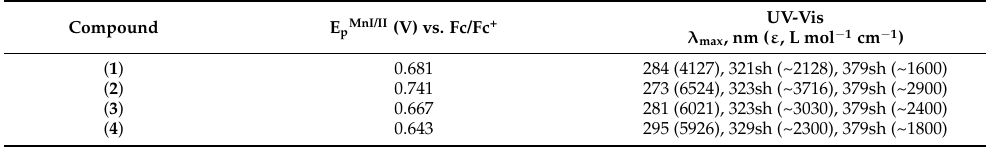
Table 2. Summarized Mn I/II oxidation potentials for compounds ( 1 )–( 4 ) in dichloromethane under argon atmosphere and λ max of absorption bands in UV-Vis for compounds ( 1 )–( 4 ) in dichloromethane. Compound